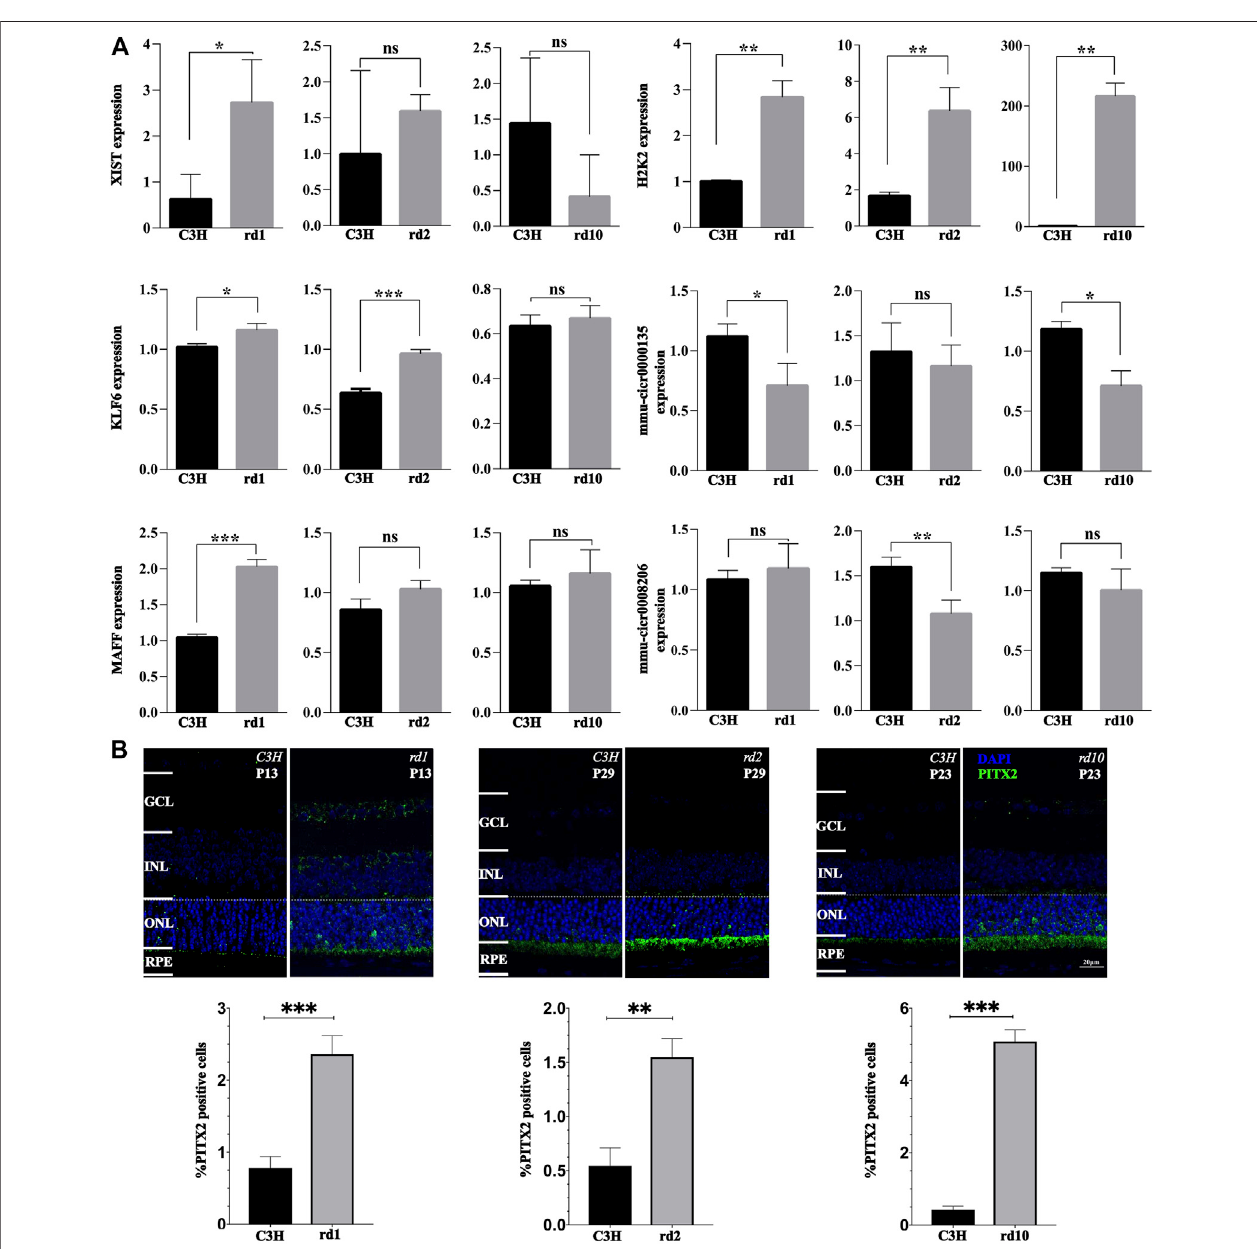
FIGURE7| ValidationofgeneexpressionchangesviaqPCRandimmuno fl uorescence. (A) TherelativelevelsofXIST,H2K2,MAFF,KLF6,mmu-circ0000135,and mmu-circ0008206 in different groups at different times determined by real-time quantitative PCR. (B) PITX2 expression in C3H wild-type, rd1 , rd2 , and rd10 retina at time-points corresponding to the peak of retinal degeneration as assessed by immuno fl uorescence. Quanti fi cation in bar graphs displays the percentage of PITX2 positive cells in the outer nuclear layer (ONL). Signi fi cance levels indicated by asterisks: * (cid:1) p < 0.05, ** (cid:1) p < 0.01, *** (cid:1) p < 0.001.